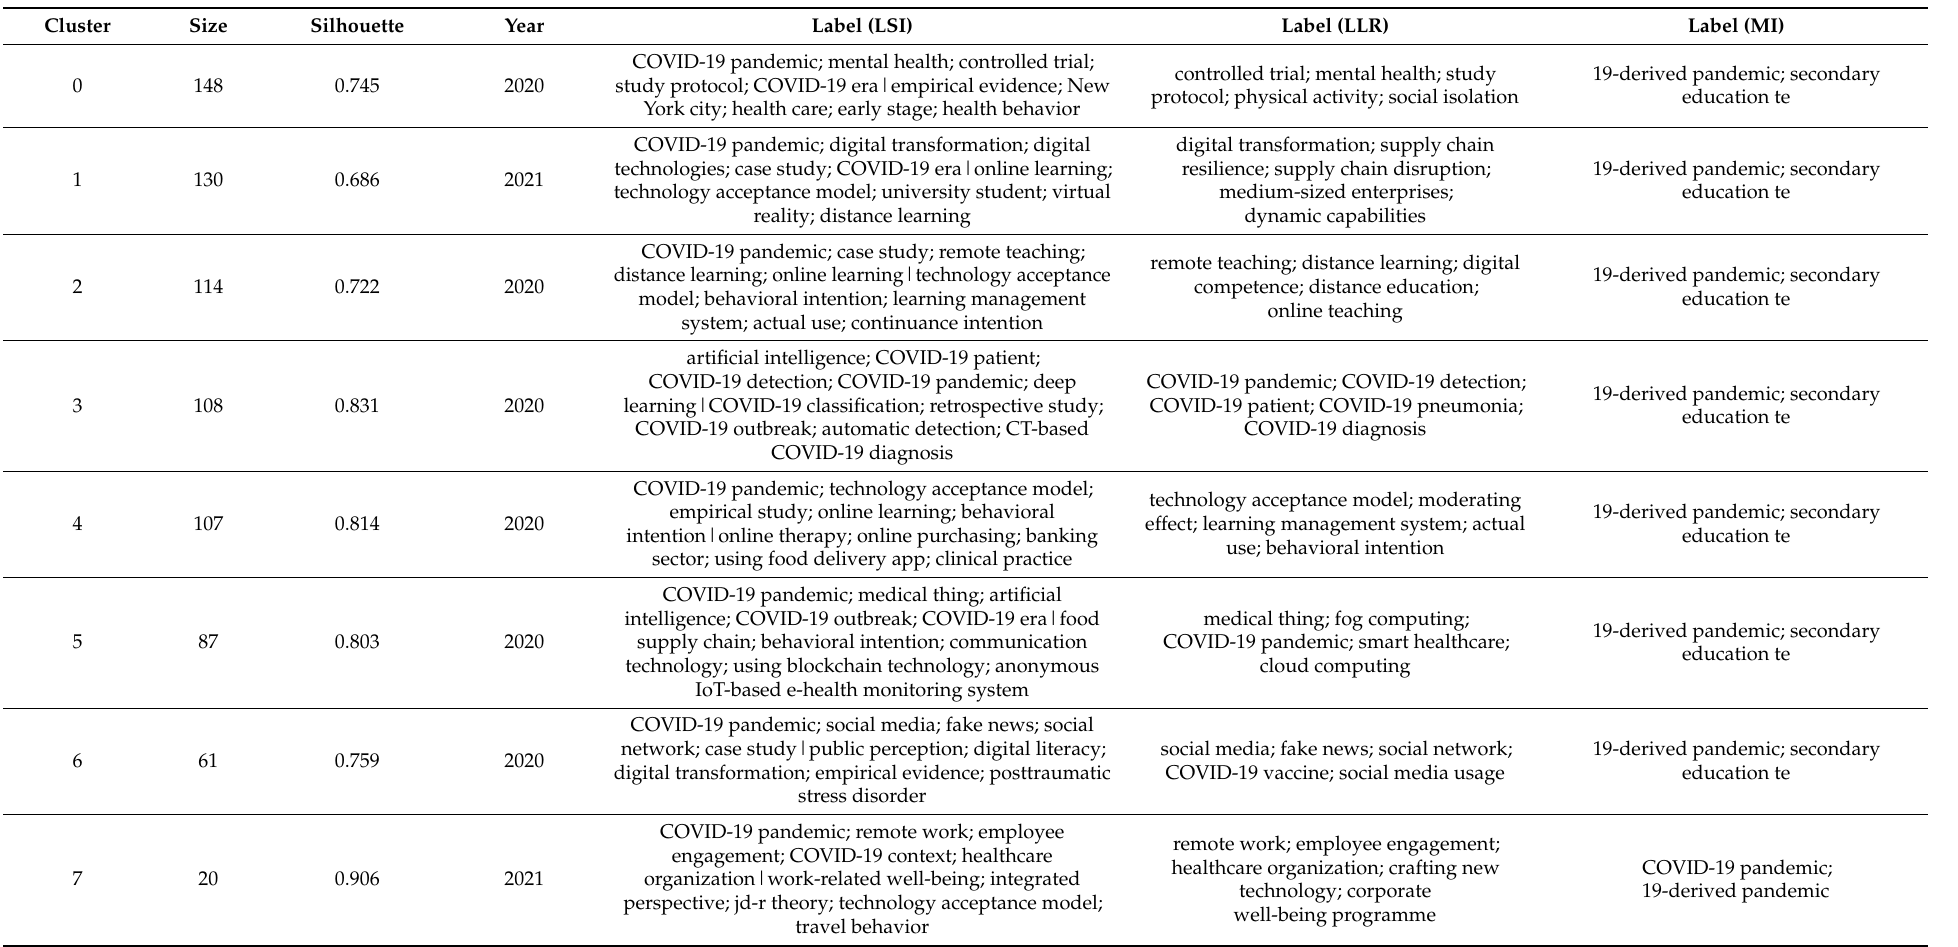
Table 4. The label list of clustering categories in the keyword co-occurrence